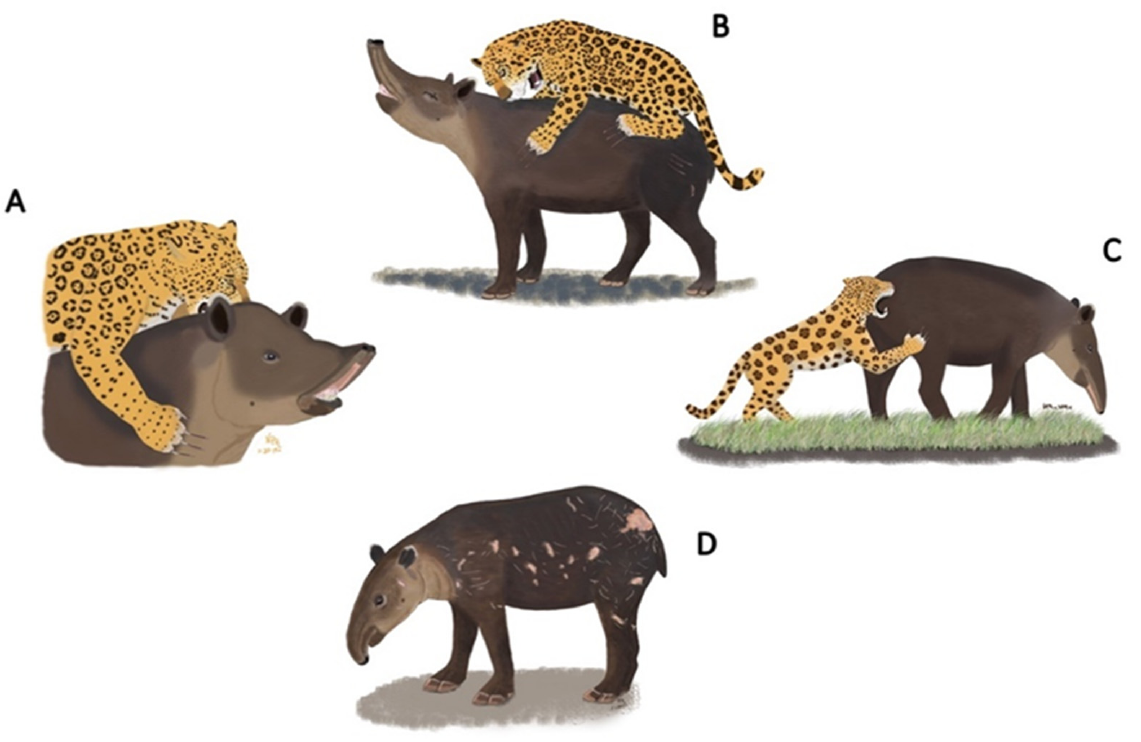
Figure 5. Recreation of an attack of jaguar on Baird’s tapir. Jaguars attack different anatomical regions: ( A ) jaguar biting and scratching the head and neck, ( B ) jaguar biting the back and scratching the body, ( C ) jaguar biting and scratching the rump and hindlegs, and ( D ) injured tapir after a jaguar attack. The MDS analysis clearly indicated an association between unhealthy individuals, dry season, injuries, and HS, while good health was associated with HA and the rainy season, and the lack of injuries was associated with LHA and the rainy season (Figure